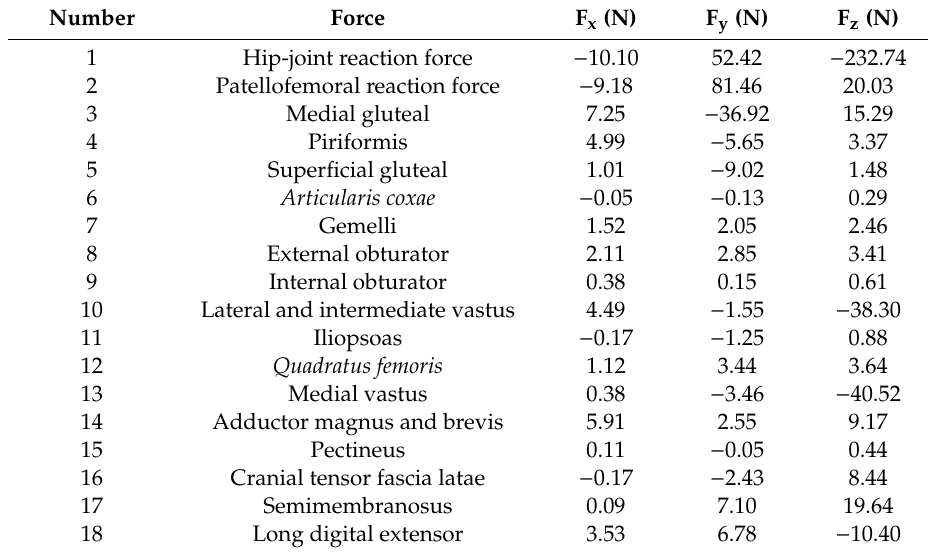
Table 2. The x, y, and z components of the joint reaction forces (numbers 1 and 2) and the muscle forces (numbers 3–18) acting on the canine left femur during a three-legged stance [25].